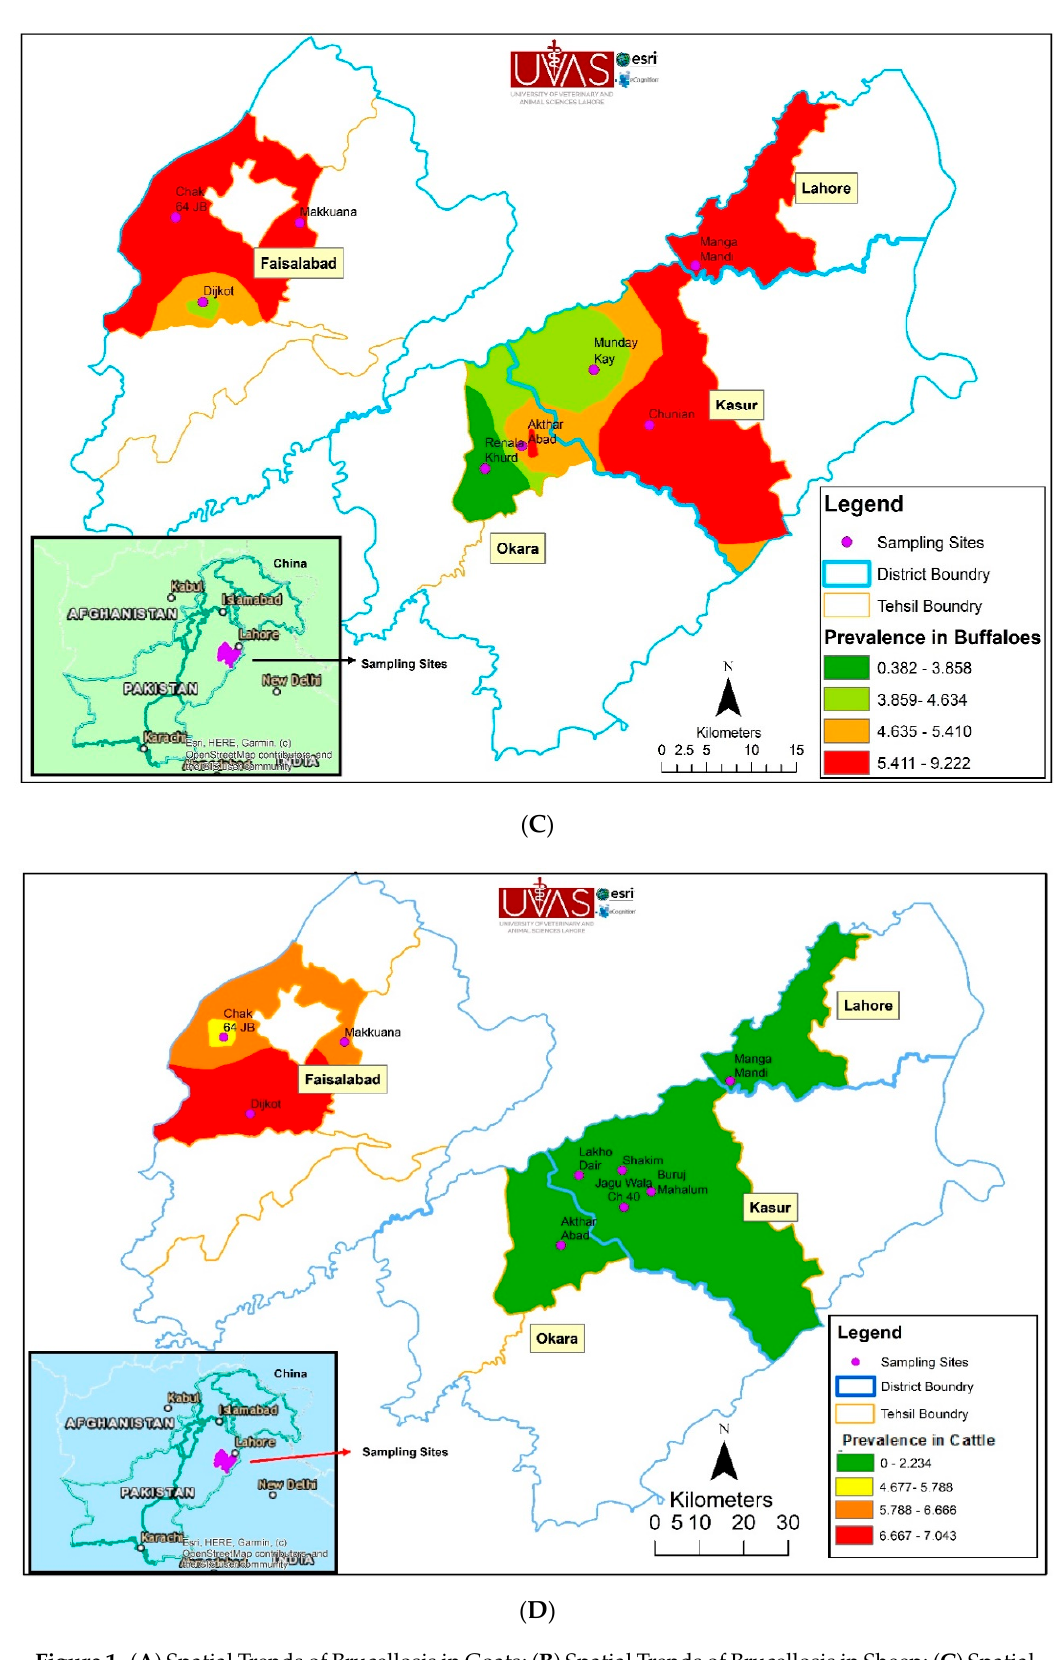
Figure 1. ( A ) Spatial Trends of Brucellosis in Goats; ( B ) Spatial Trends of Brucellosis in Sheep; ( C ) Spatial Trends of Brucellosis in Buffaloes; ( D ) and Spatial Trends of Brucellosis in Cattle in Punjab, Pakistan.